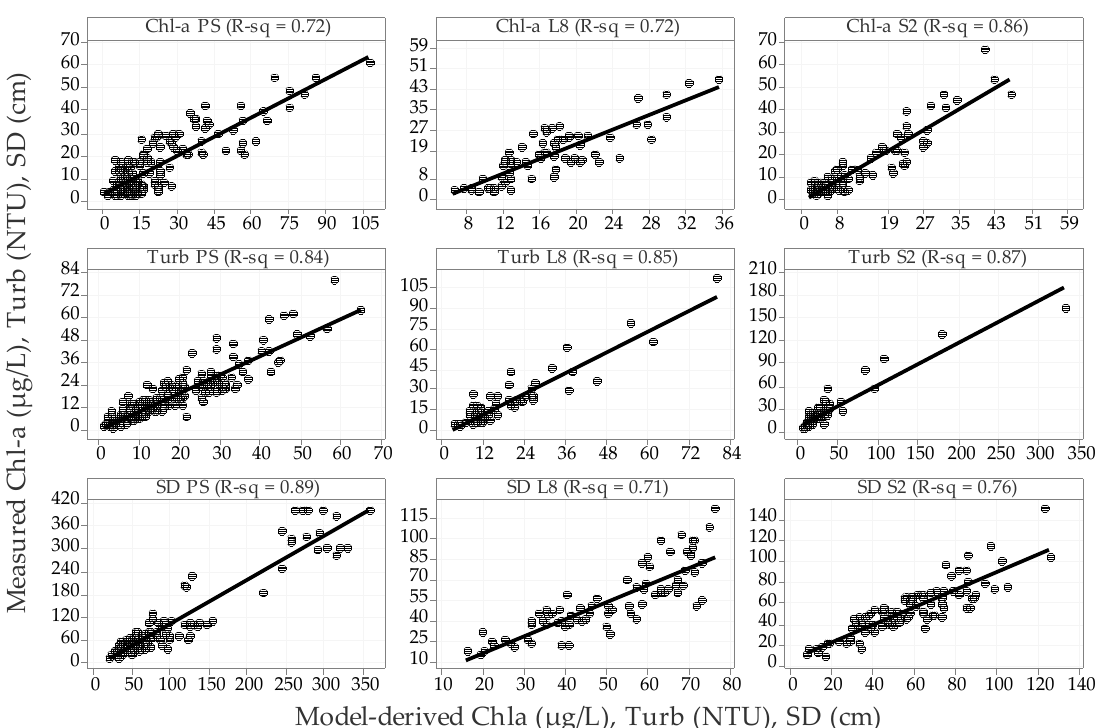
Figure 4. Scatter plots showing relationships between the model-derived concentrations and measured concentrations of Chl-a ( µ g/L), Turb (NTU), and SD (cm) with PS, Landsat-8 (L8), and Sentinel-2 (S2). The R 2 (R-sq) values are displayed at the top of each graph along with the associated parameters and satellite platforms.